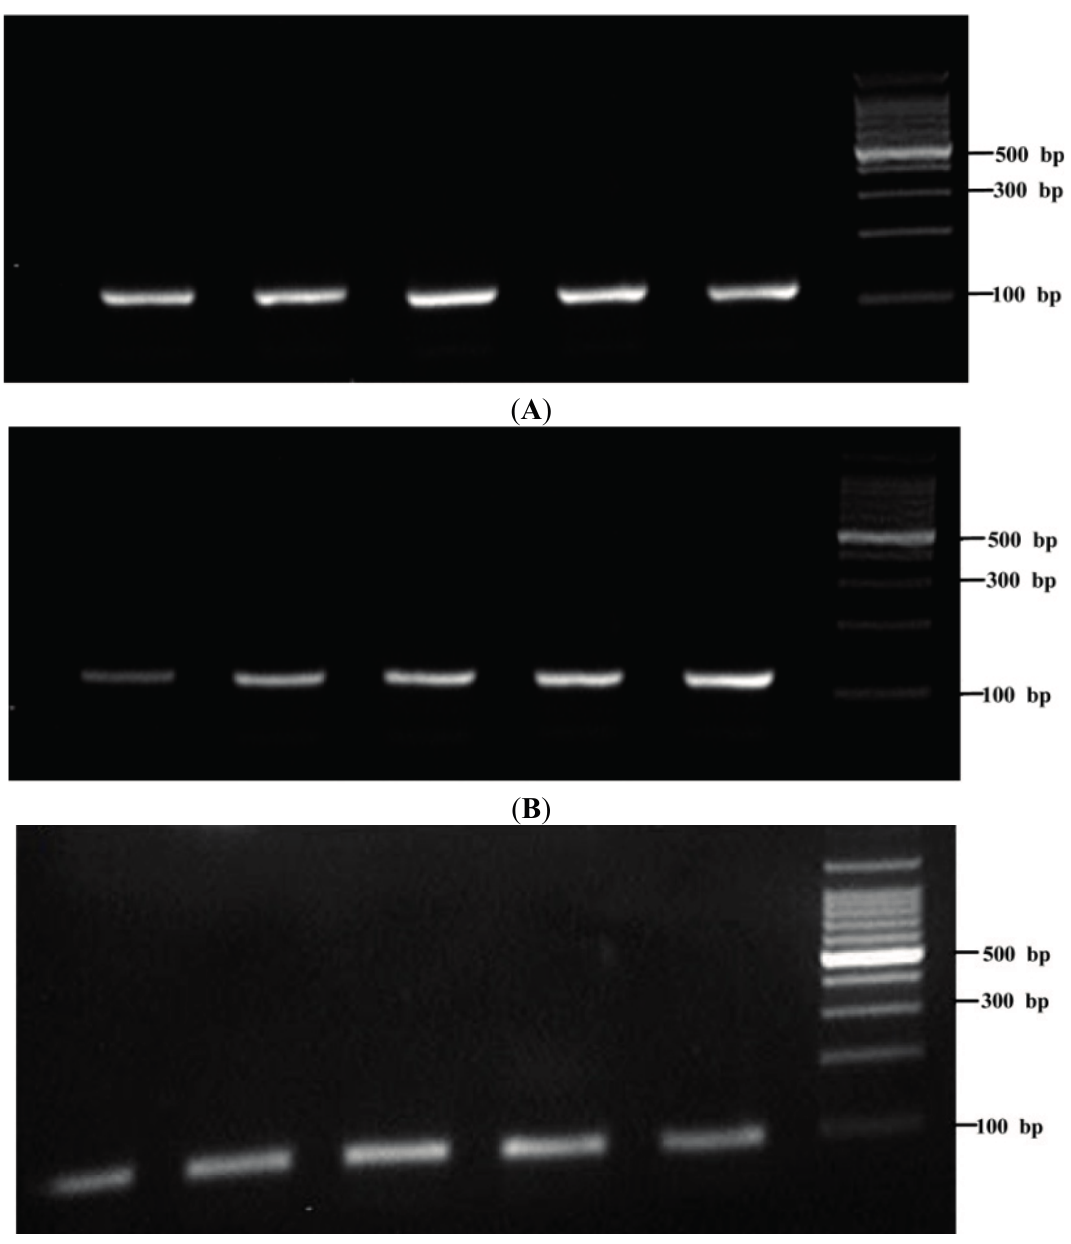
Figure 5. RT-PCR amplification of Sap1 ( A ); Sap2 ( B ); Sap3 ( C ); Sap4 ( D ); Sap5 ( E ); and ACT-1 ( F